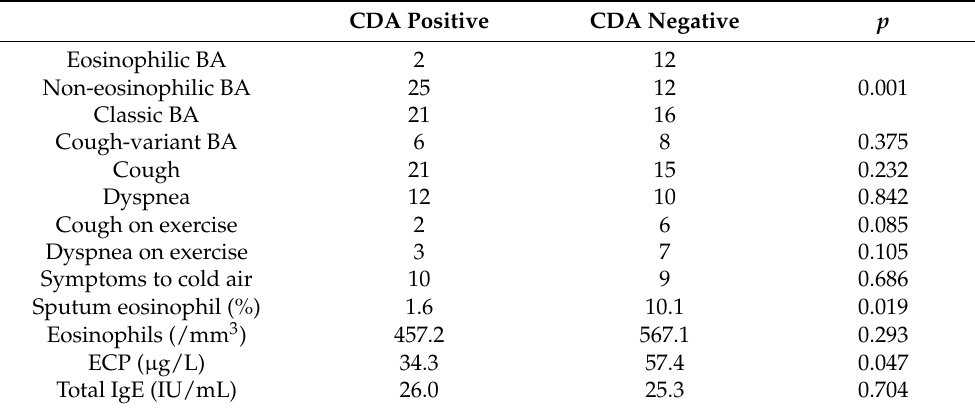
Figure 1. Numbers of positive CDA provocation tests in asthma patients. CDA—cold dry air. Table 4. Comparisons between CDA positive and CDA negative subjects in asthma